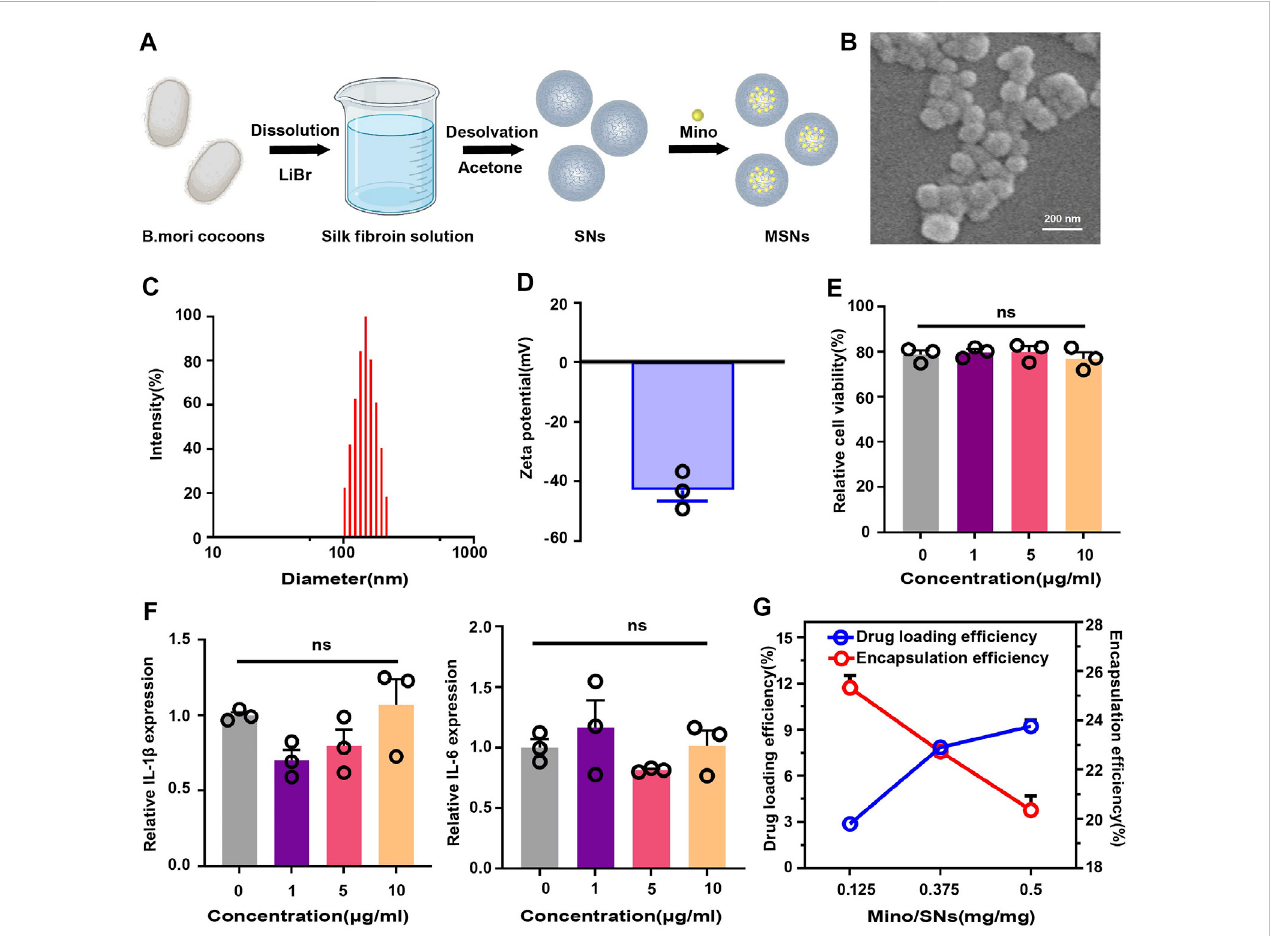
FIGURE 2 Characterizationofsilk fi broinnanoparticles. (A) Schematicillustrationofthesynthesisofdrug-loadedSNs. (B) ScanningelectronmicroscopyofSNs. (C) Particle size distribution of SNs. (D) Zeta potential diagram of SNs. (E) CCK-8 of SNs. (F) RT-PCR of SNs at different concentrations. (G) Drug loading and encapsulation ef fi ciency for different mass ratios of Mino and SNs. Data are presented as means ± SEM, ns p > 0.5; by one-way analysis of variance (ANOVA) with Tukey ’ s post hoc test (E and F)